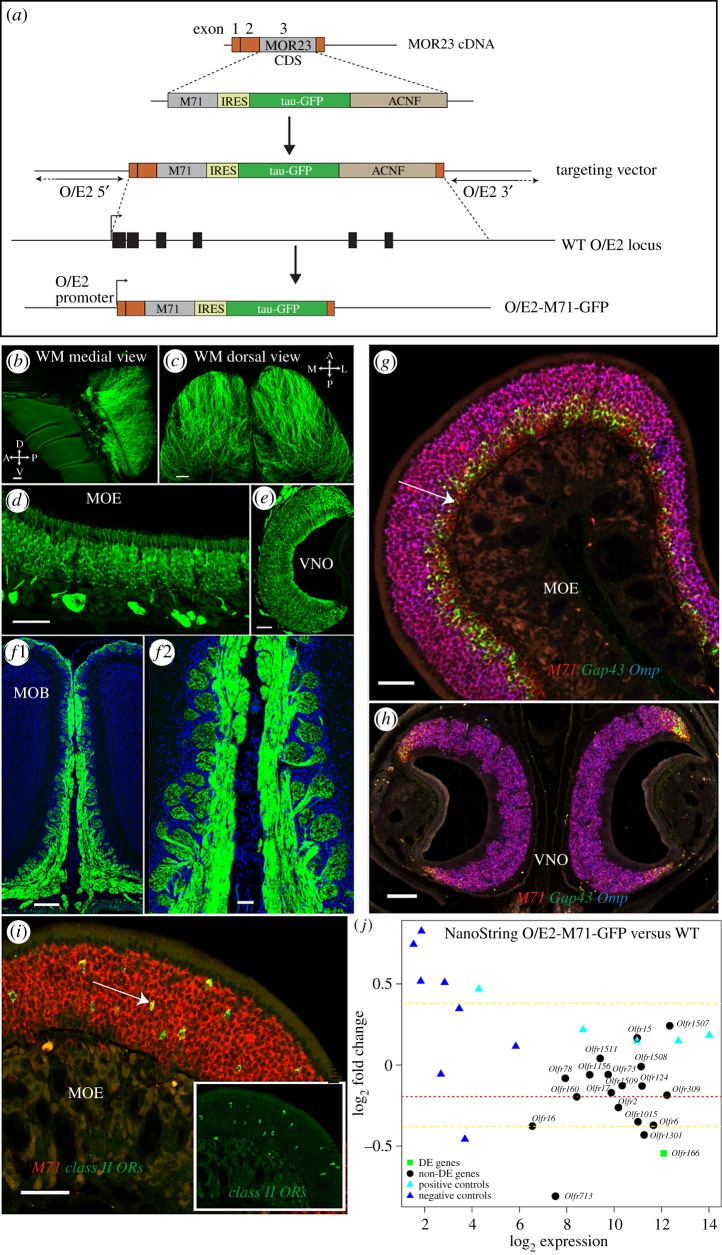
OSNs in O/E2-M71-GFP mice ubiquitously express M71 together with an endogenous OR. (a) Schematic of the O/E2-M71-GFP mutation. (b,c) Wholemount (WM) intrinsic GFP fluorescence of the medial and dorsal olfactory bulb in O/E2-M71-GFP+/− mice (3wo). (d–f) Intrinsic GFP fluorescence in coronal sections of the (d) MOE, (e) VNO and (f1, high magnification in f2) MOB of O/E2-M71-GFP+/− mice (3wo). (g,h) Three-colour ISH against M71 (red), Gap43 (green), Omp (blue) in the (g) MOE and (h) VNO of O/E2-M71-GFP+/− mice (3wo). Arrow shows an example of an OSN expressing M71 before the onset of Gap43. (i) Two-colour ISH in the MOE of O/E2-M71-GFP+/− mice, using probes against M71 (red) and a mix of four different class II OR (see the electronic supplementary material) genes (green and inset). Arrow shows an example of a double positive cell. (j) NanoString RNA analysis of whole olfactory mucosa samples collected from six WT and six O/E2-M71-GFP heterozygous littermates (PD25), using a code set against 19 ORs. The values in the y-axis represent the log2 of the fold change of mutant versus WT (i.e. M value). Positive values represent an increase in expression, while negative values are a reduction. The values in the x-axis represent the log2 of the normalized NanoString counts, which is a measure for both the expression level of the OR and the binding efficiency of the probe. To test for significance, tTreat analysis was used, with a fold change threshold set at 1.3. Differentially expressed genes are indicated as green squares. Red stippled line: the average M value of all tested OR genes; Yellow stippled lines: the chosen fold change threshold (set at 1.3, in log2 scale = 0.38). Positive controls (cyan triangles) and negative controls (blue triangles) for NanoString operation are distributed correctly as per manufacturer. Scale bars, 250 µm (b,c,f1), 50 µm (d,e,f2,g,i), 100 µm (h).